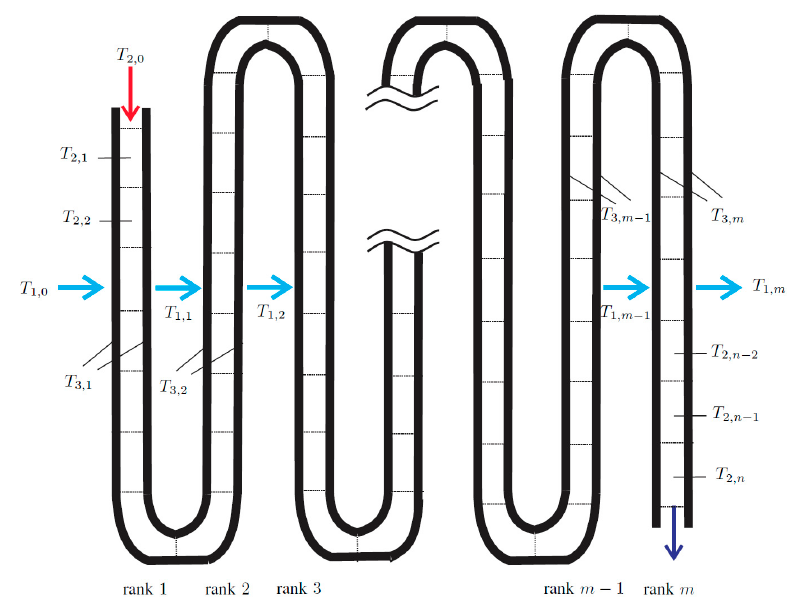
Figure 3. Sketch of the coil with the discretized state variables. Based on the aforesaid, it is possible to discretize and derive the corresponding Laplace representation in the complex domain s ∈ C